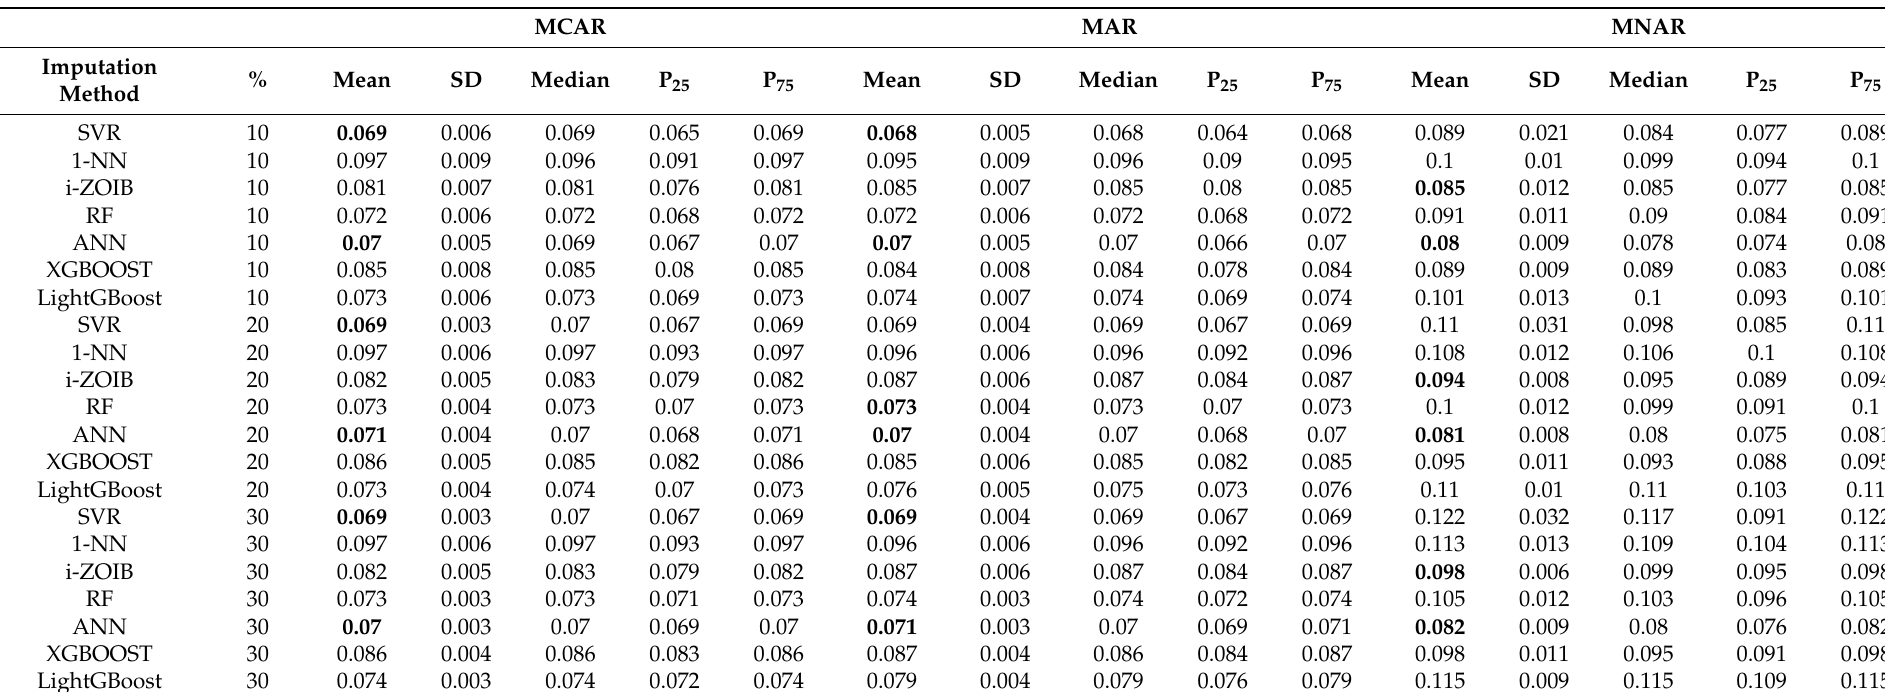
Table A4. Summary statistics of the RMSE accuracy measure according to the missingness mechanisms, rates and imputation methods in the Scenario 2. MCAR MAR